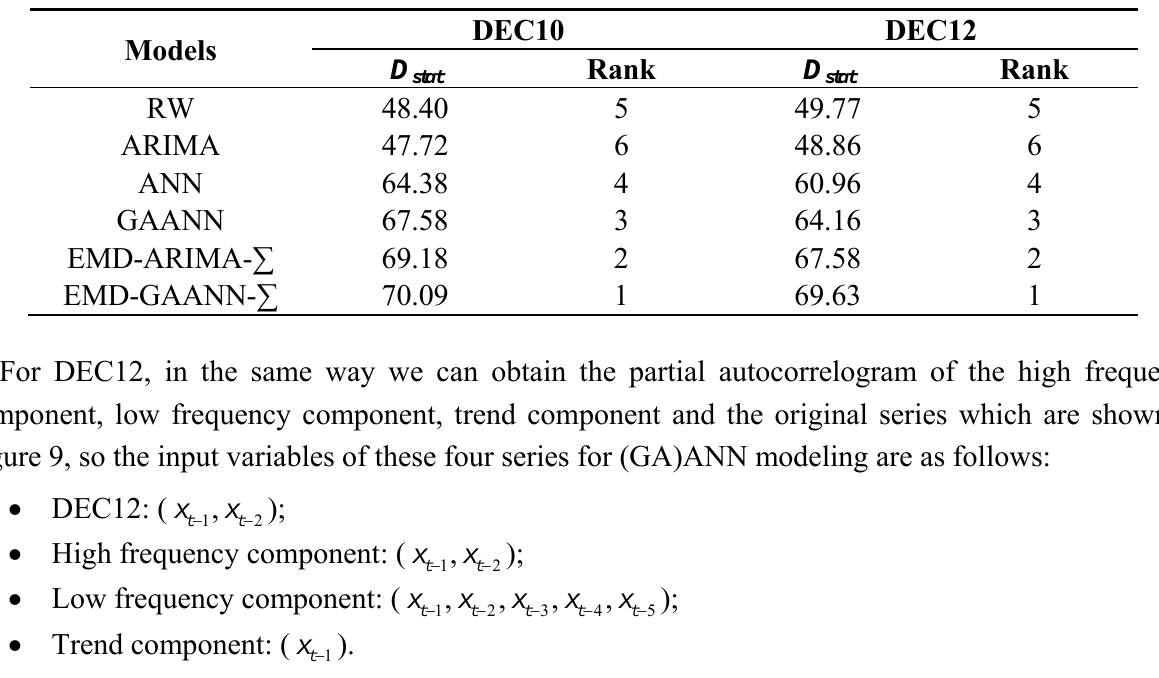
comparisons for different forecasting Table 4. D stat